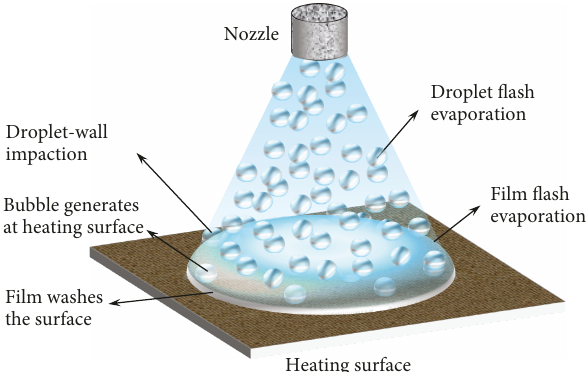
Figure 5: The complete vacuum fl ash evaporation spray cooling